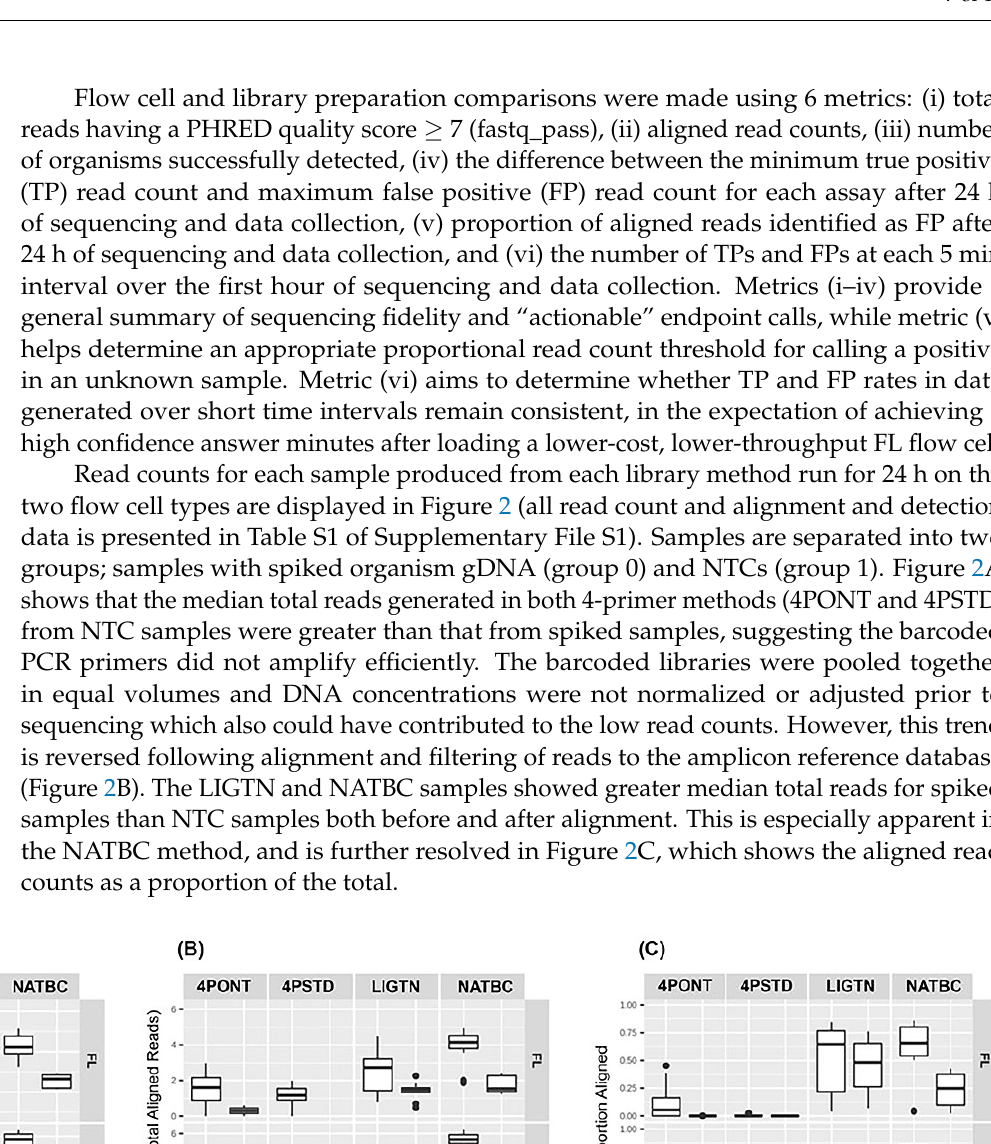
Figure 3. Detected organism counts. Counts for each method out of a total of 36, per method per flow cell type (Green is detected, Pink is not detected). Detection in this analysis means all expected amplicons had a filtered aligned read count ≥ 1. NTCs are not included. In order to determine how individual assays from the 23 ‐ plex cocktail performed fol ‐ lowing each library preparation strategy, the difference between the minimum TP and maximum FP aligned filtered read count per amplicon was calculated (Figure 4). Here, a larger value indicates a greater spread between these two values and lower probability of returning a FP detection. Again, samples prepared using the NATBC method and run on